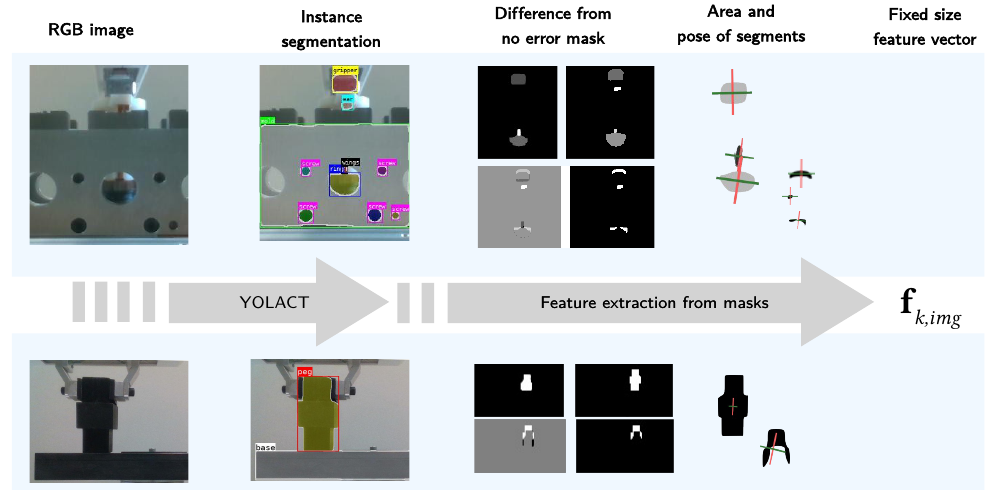
Figure 9. Image features extraction pipeline. The RGB snapshot of a situation is processed by a YOLACT model to obtain masks of different parts of interest. The obtained masks are then processed to obtain a low-dimensional fixed-size feature vector.